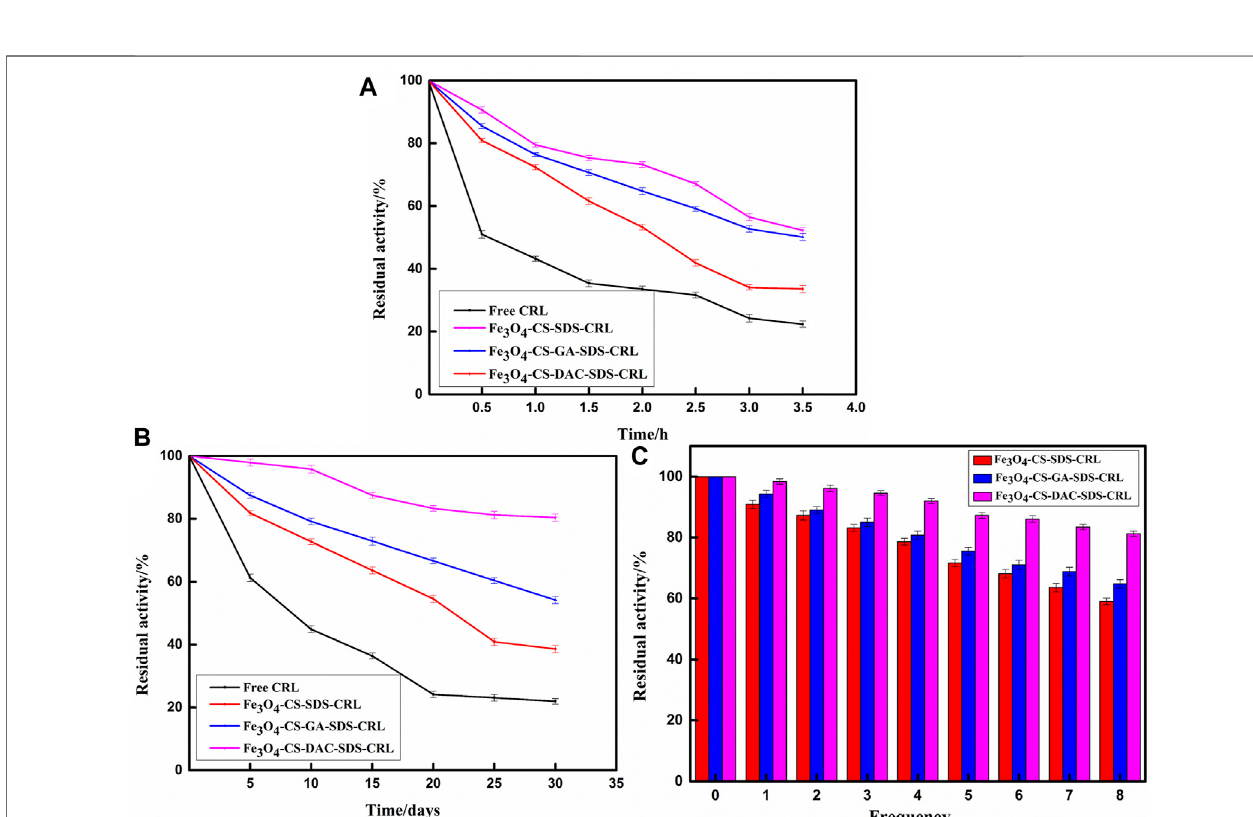
FIGURE 6 | Studies on thermal stability (A) , storage stability (B) , and reusability (C) .